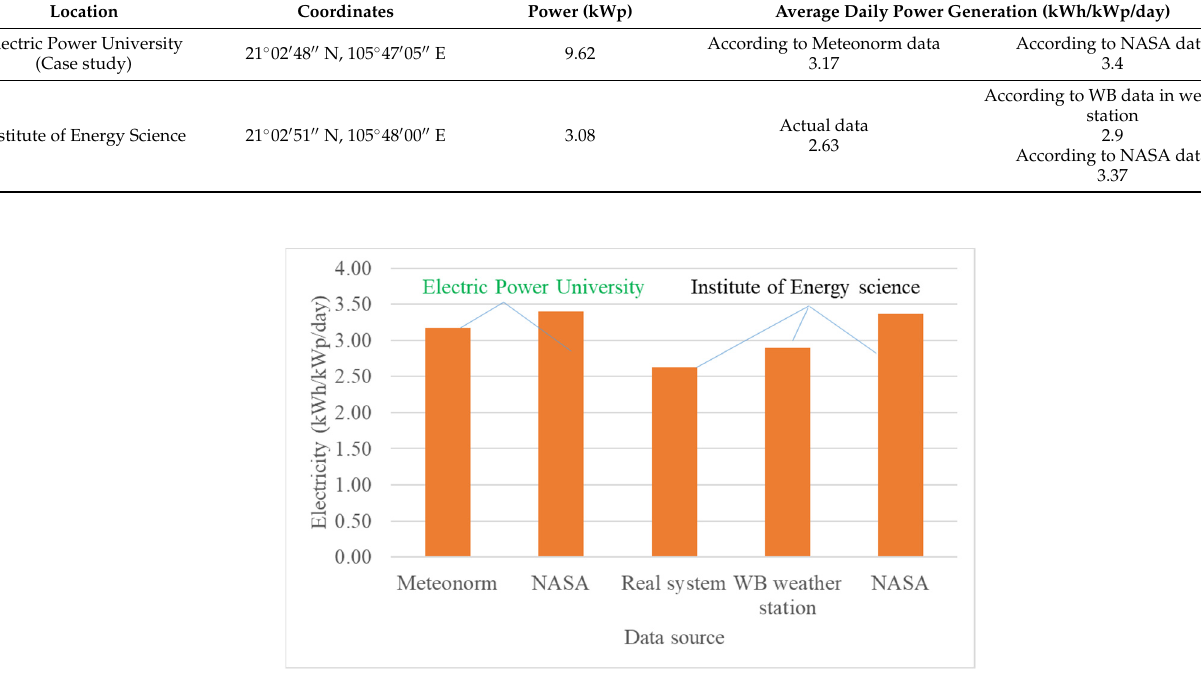
Table 6. Comparison parameters of PV power stations in the world.